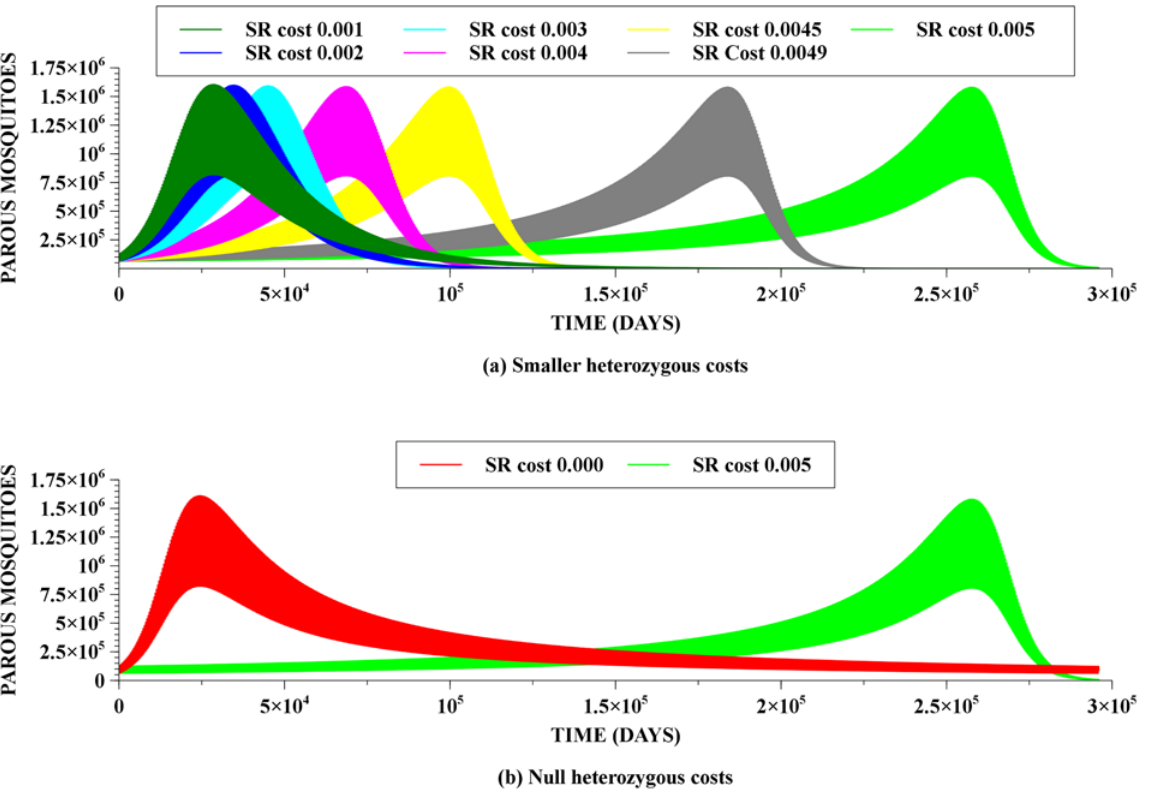
Fig 9. Dependence of reversal time on different costs for heterozygous individuals. Homozygous resistance cost was kept at 0.005. In 9(a) we have smaller, but non-zero heterozygous costs. Notice that reversal times are significantly smaller. In 9(b) we have null heterozygous costs. Again, there is a noticeable reduction in reversal time, but in this case notice a fatter tail for the heterozygous genotype